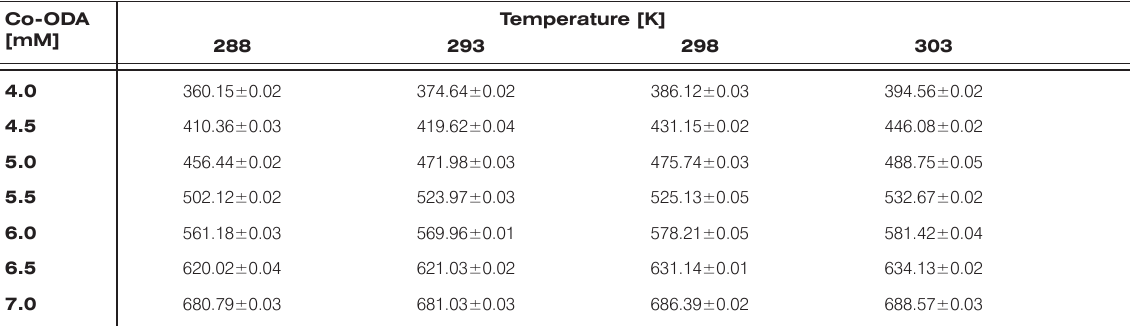
Table 5. Concentration and temperature dependences of rate constants k (s -1 ) (± standard derivation) of the substitution of Co-ODA with bipy. The concentration of bipy is constant and is equal to 2.88 mM. Co-ODA